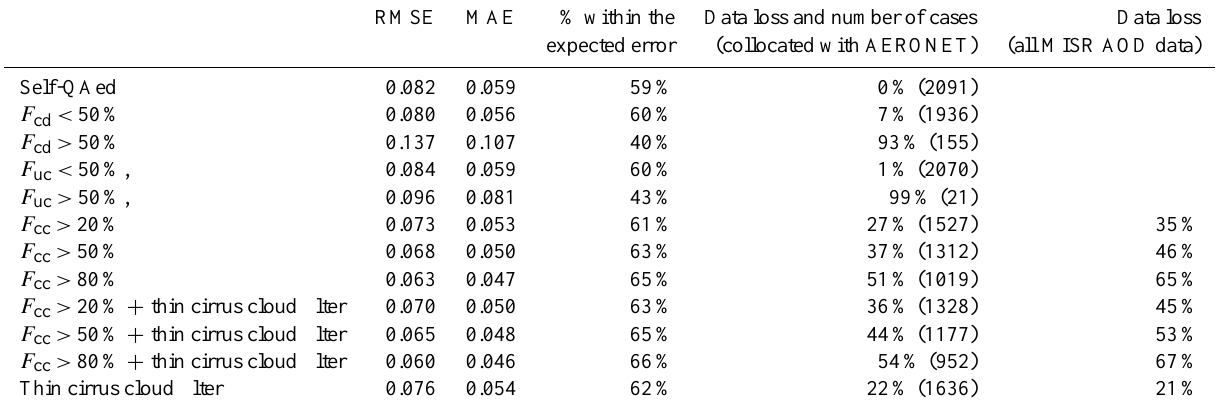
Table 1. The RMSE, the MAE, the fraction of data within the expected error (0.05 or 20% of AOD AERONET ) , and the data loss rates (both for the MISR AOD data that are collocated with AERONET data and for all MISR AOD data) under 12 conditions over oceans. F cd is the cloudy fraction, F uc is the uncertainty clear fraction, and F cc is the confident clear fraction. The thin cirrus cloud filter refers to thin cirrus cloud free (set F cirrus_free = 100%) as detected by MODIS. The percentages of data loss are presented and the numbers enclosed in the parentheses are the total number of the paired data that passed the data screening criteria.